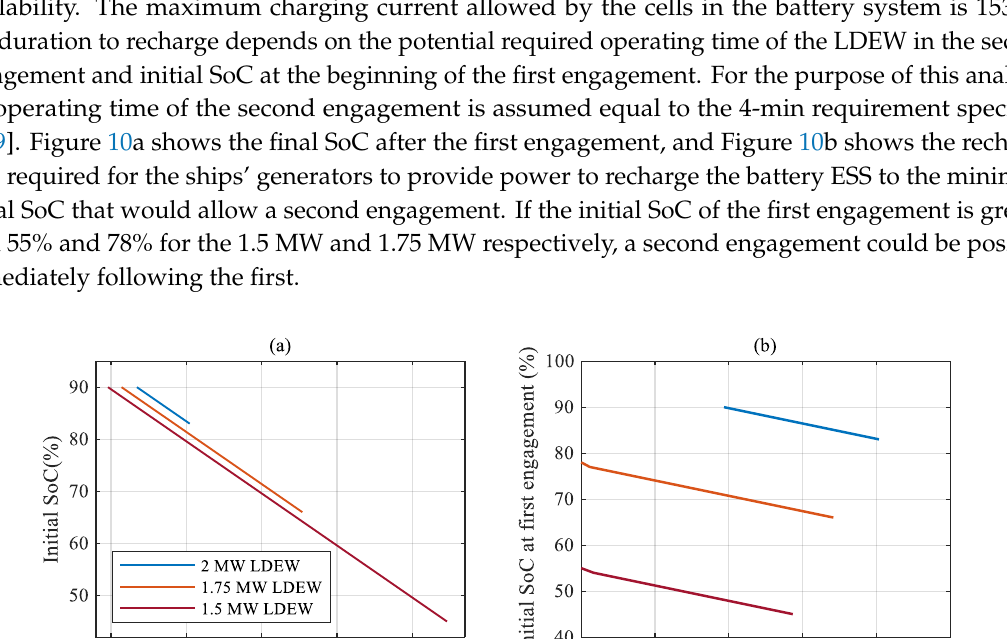
Table 5. Degraded battery performance test matrix based on [31,32].